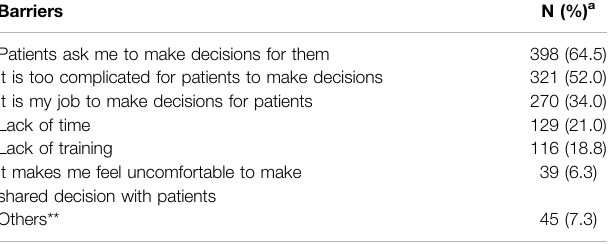
TABLE 4 | Physicians ’ barriers to the implementation of shared decision-making Barriers N (%) a Patients ask me to make decisions for